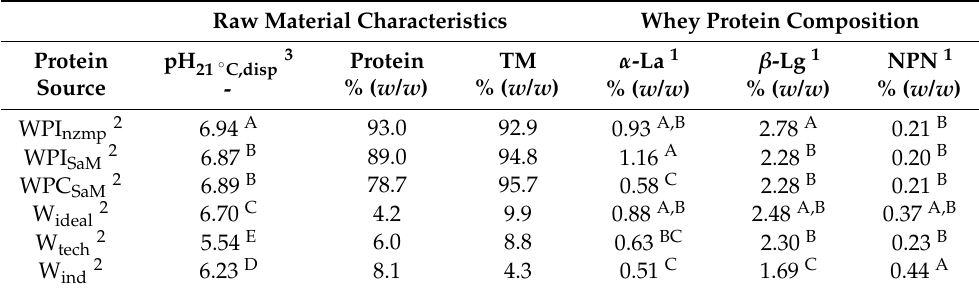
Table 1. Raw material characteristics and composition of dispersions of whey protein powders and whey protein